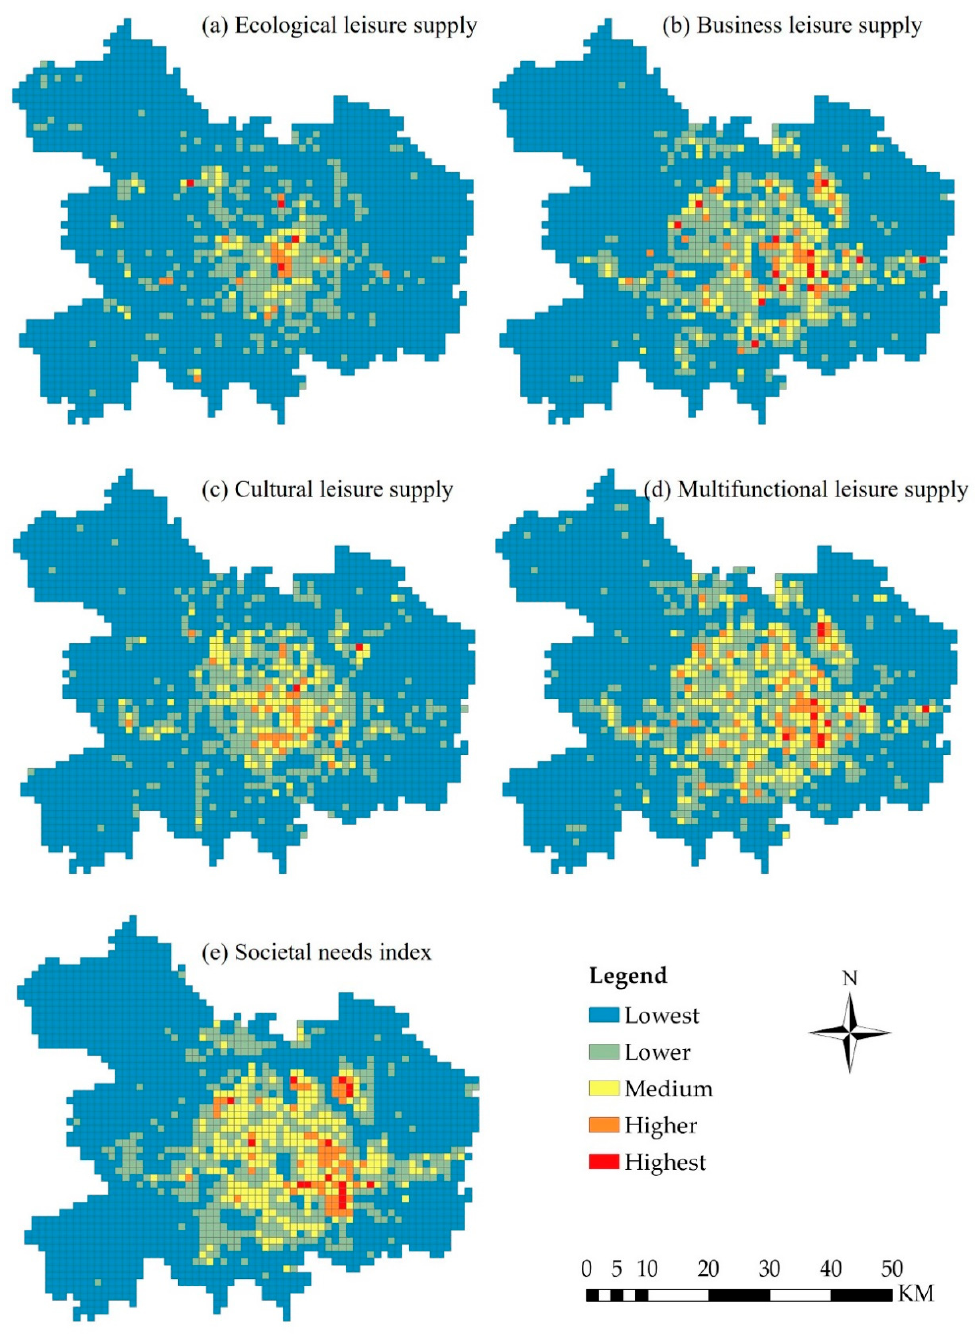
Figure 4. LS supply and demand maps for 2019.